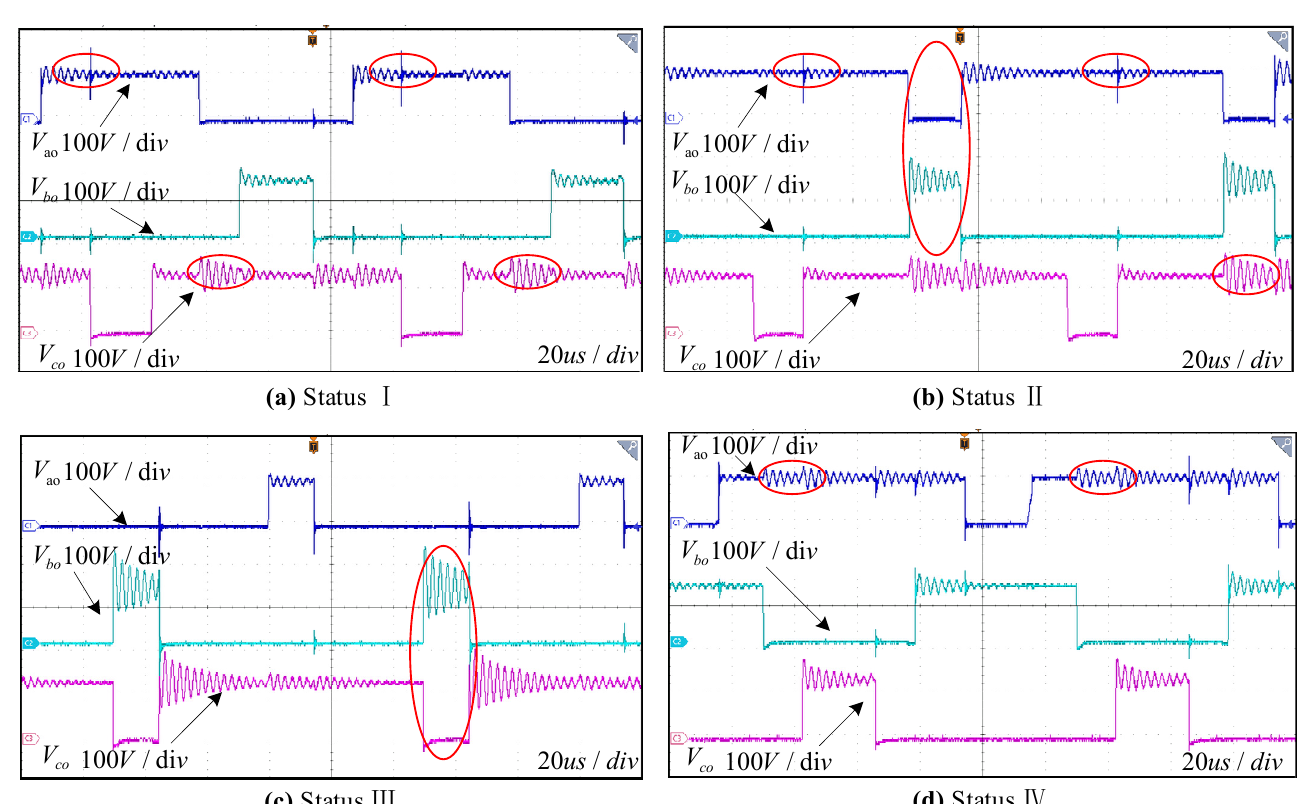
Figure 10. Three-phase voltage waveform of AZSPWM different switching Figure 10. Three ‐ phase voltage waveform of AZSPWM d ifferent switching states .